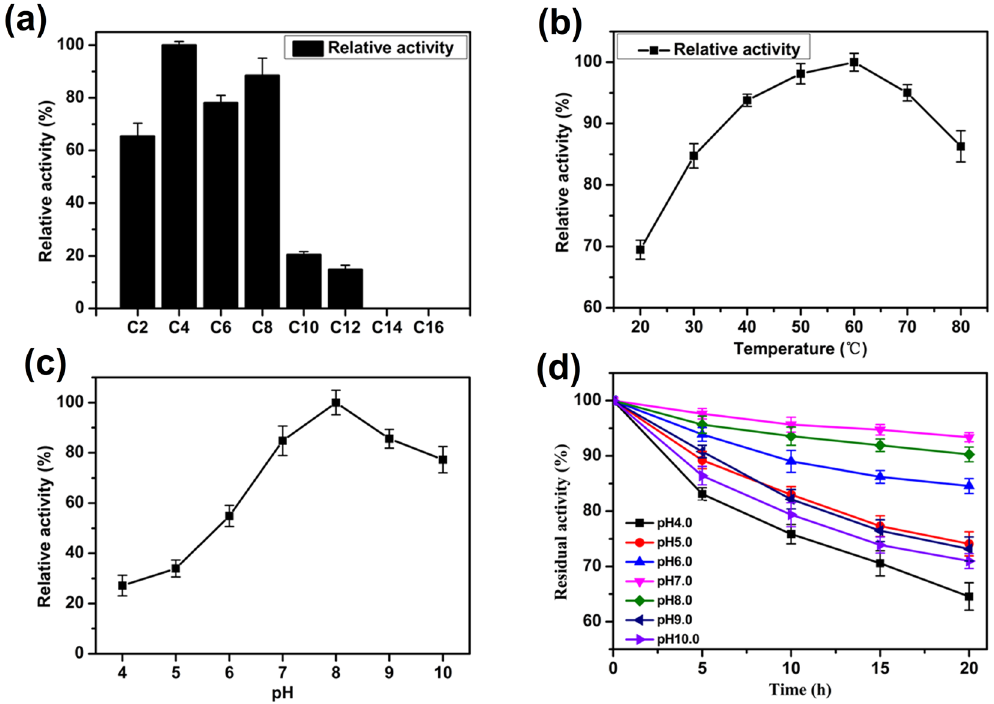
Figure 4. Characterization of recombinant EstPS1. ( a ) Determination of the optimum substrate for EstPS1. The relative activity (%) was obtained by comparison of the substrates (C4). ( b ) Optimum temperature of p -nitrophenyl butyrate for EstPS1 activity. ( c ) Optimum pH of p -nitrophenyl butyrate with EstPS1. ( d ) pH stability of p -nitrophenyl butyrate with EstPS1 in different buffers for 20 h at 30 °C.